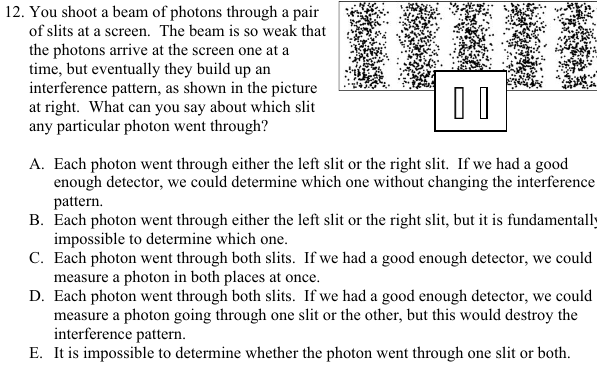
FIG. 5. Question 12 tests student understanding of the wave-